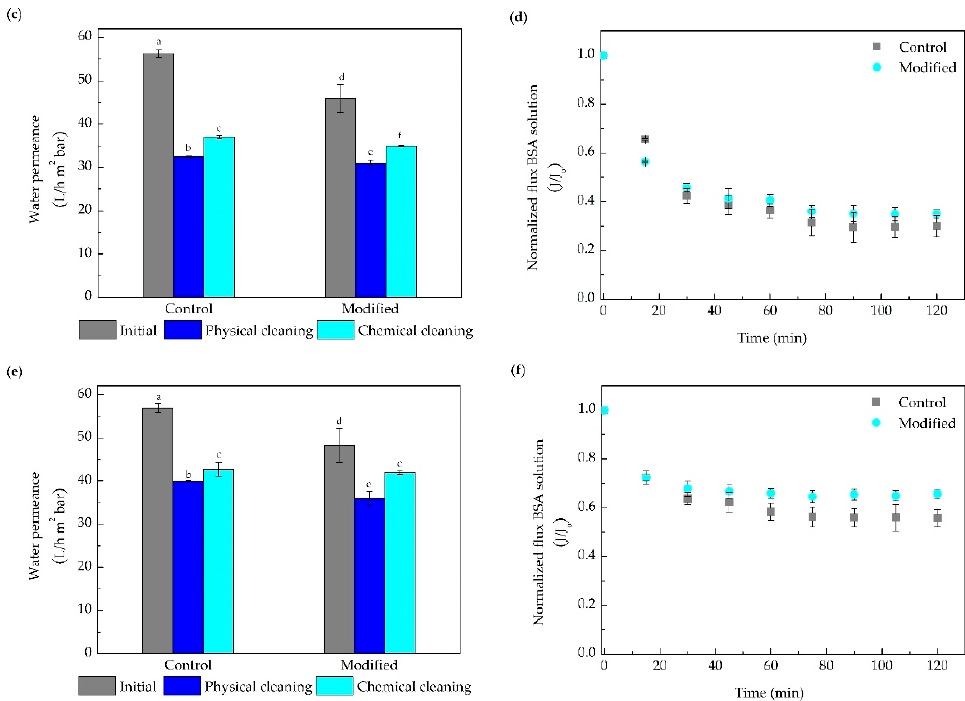
Figure 4. Water permeance before the protein filtration (initial) and after the physical and chemical cleaning for the membranes ( a ) UP020, ( c ) UH030, and ( e ) UH050. Normalized permeate flux of the BSA solution ( b ) UP020, ( d ) UH030, and ( f ) UH050. Bars with different letters show a statistical difference ( p < 0.05).